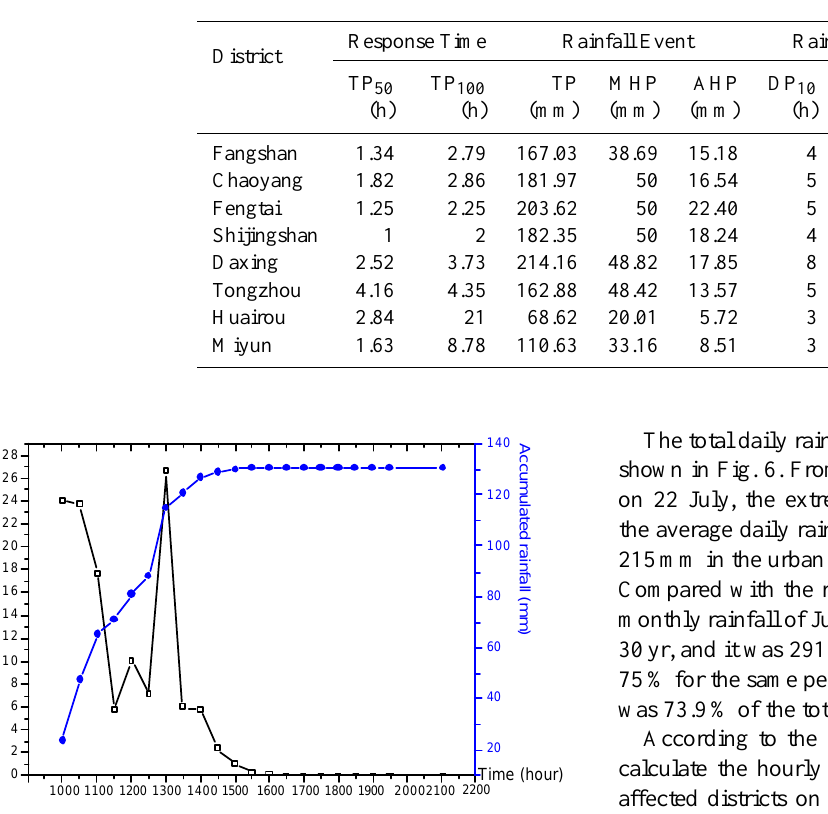
Table 3. Data of the extreme rainfall parameters of the eight affected districts on 21–22 July 2012 in Beijing.